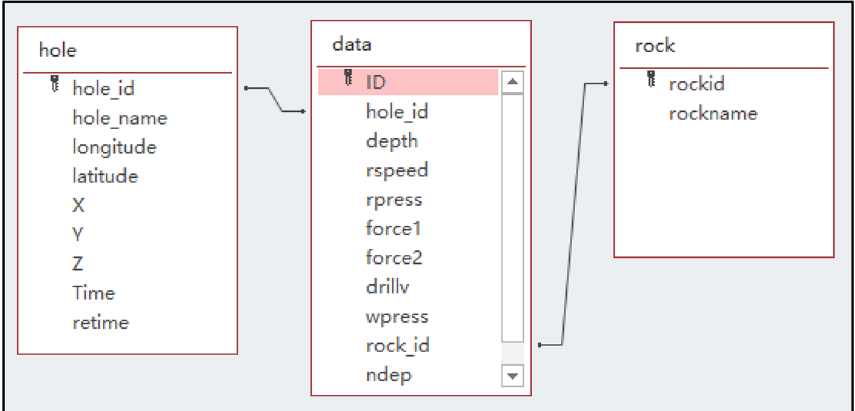
Figure 1. Relationship between the data tables.